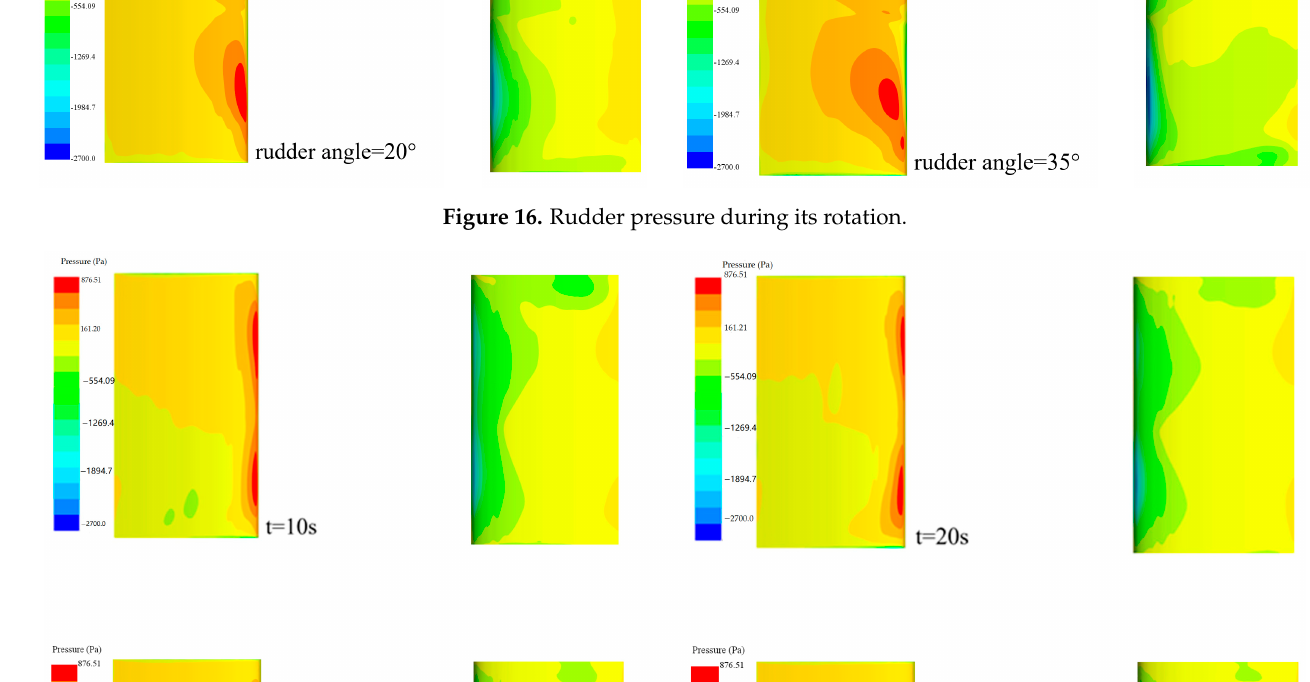
Figure 17. Rudder pressure during transition phase.